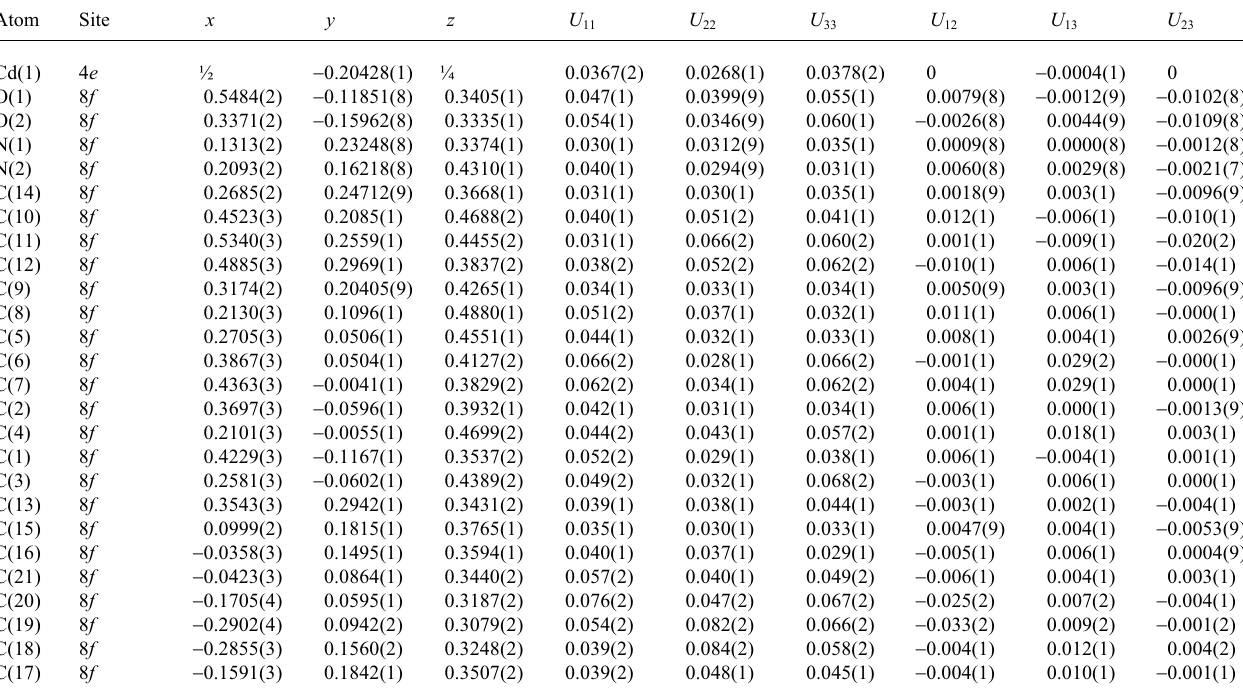
Table 3. Atomic coordinates and displacement parameters (in Å 2 )